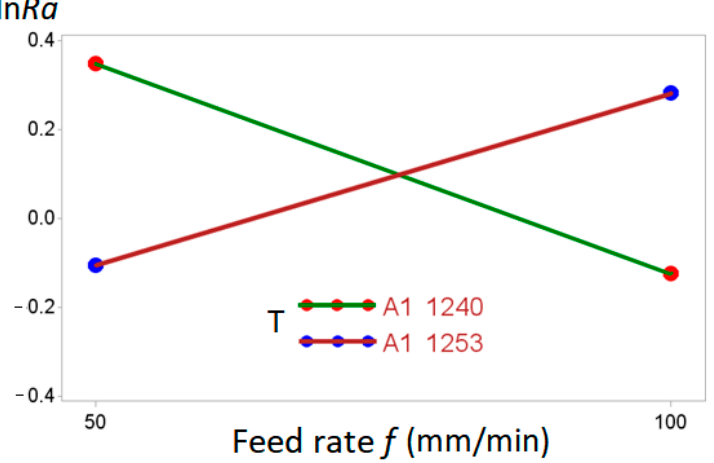
Figure 9. ln Ra interaction between type of tool and feed rate T*f .